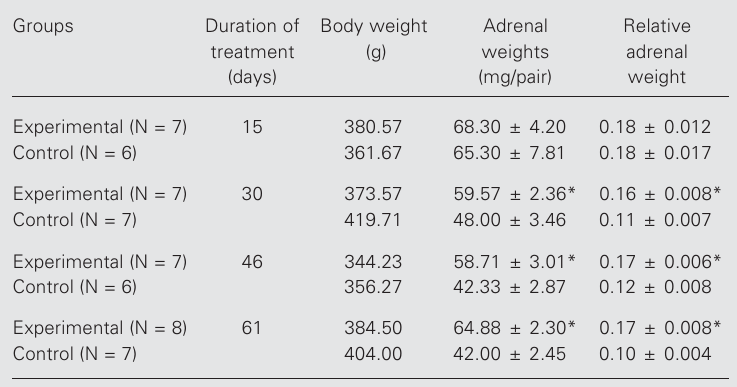
Table 1. Effect of hyperprolactinemia induced by domperidone on adrenal weights of adult rats.